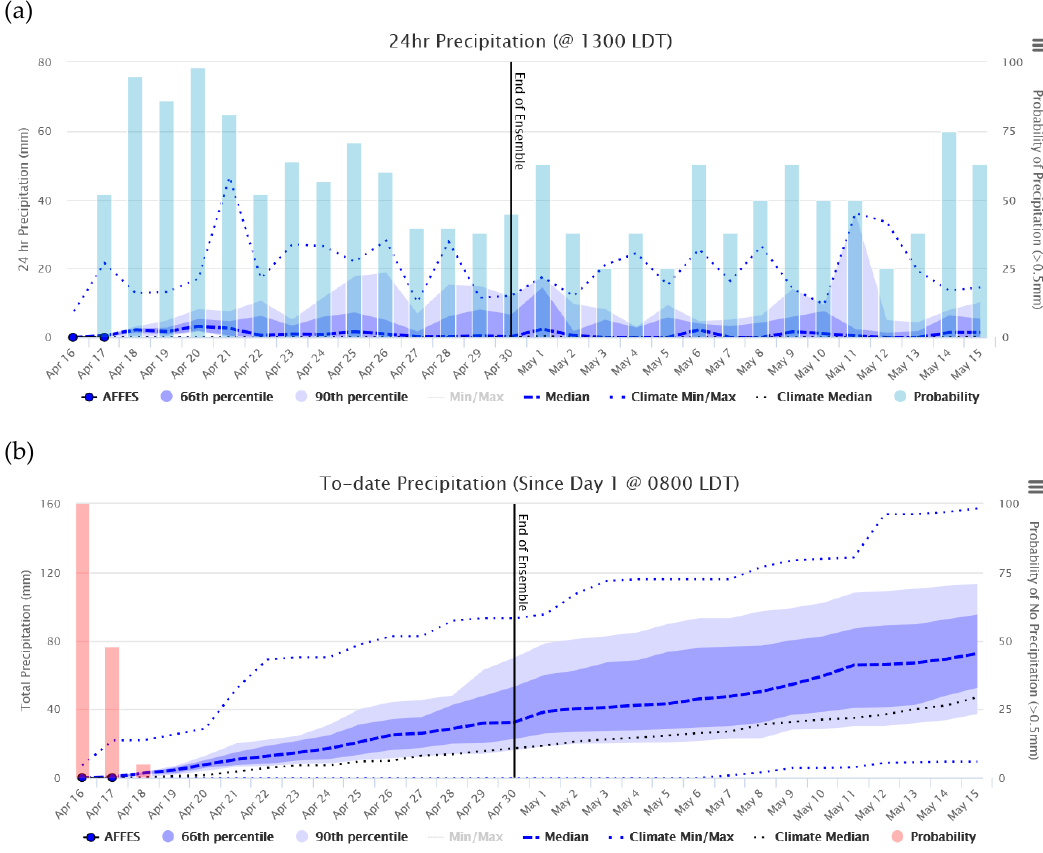
Figure 9. ( a ) Daily precipitation and the daily probability of precipitation > 0.5 mm; ( b ) to-date precipitation and the to-date probability of no precipitation > 0.5 mm / day. The bars correspond to the right y -axis.